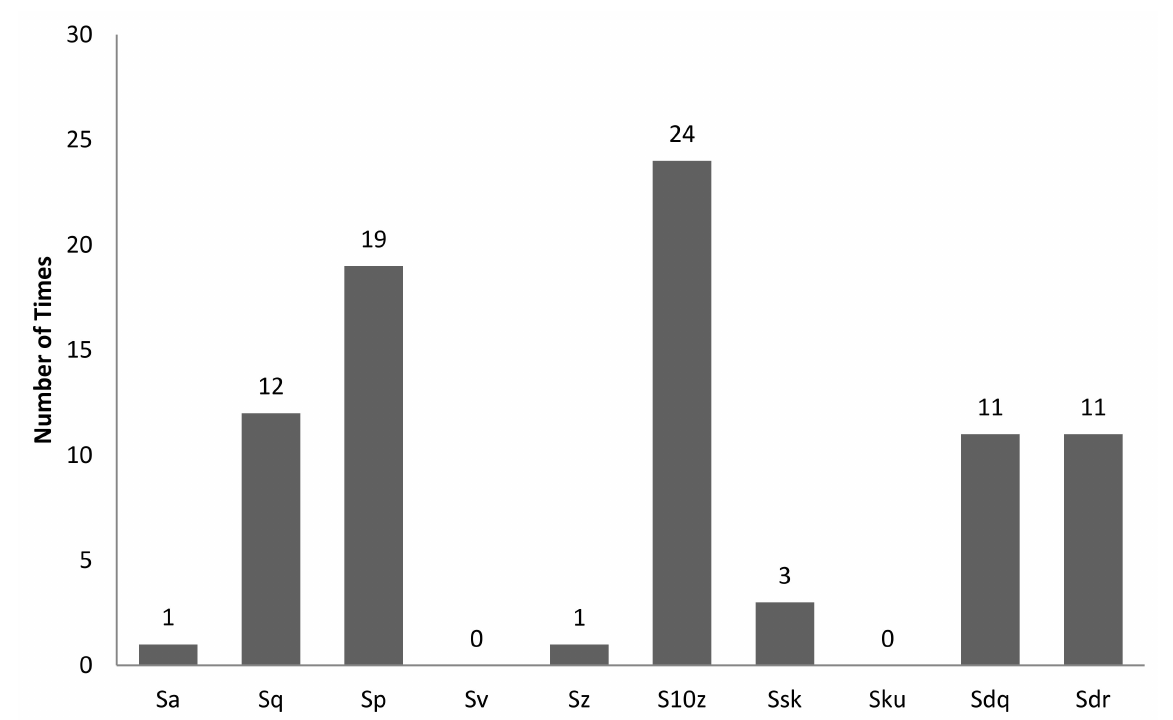
Figure 15. Bar chart showing the number of times a 3D surface roughness parameter was involved in correlation with R 2 ≥ 0.7 for an illumination angle of 60 ◦ for experimental setup 1.